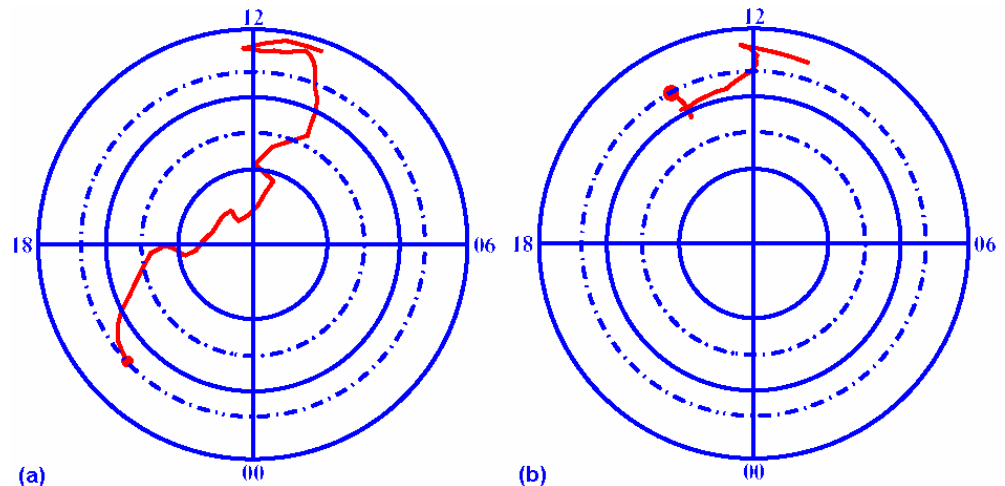
Fig. 8. Path history during the four preceding hours of the magnetic flux tube arriving (red dot) at 18:00 UT above Tromsø on 17 February, left-hand side ( a ) and at 11:20 UT on 16 February, right-hand side ( b ) . The tube trajectories (red lines) and the location of EISCAT-Tromsø radar (outer dashed circles) are plotted in the MLT frame between 60 ◦ and 90 ◦ magnetic latitude.